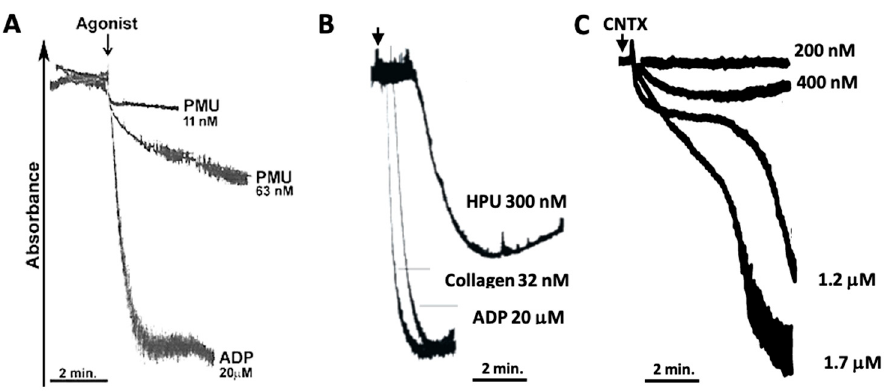
Figure 1. Aggregation of platelets induced by P. mirabilis urease and other ureases. Turbidimetric assay of platelet aggregation induced by ureases. The reaction started by addition of the agonist (urease, ADP, or collagen) to a platelet-rich plasma suspension and the aggregation response (a decrease in absorbance at 630 nm) was monitored for 5 min. The tracings were superimposed to facilitate comparison. Panel ( A ) aggregation of human platelets in the presence of PMU (11 and 63 nM) or 20 µM ADP. Typical results. Panel ( B ) aggregation of rabbit platelets in the presence of H. pylori urease (HPU, 300 nM), collagen (32 nM) or ADP (20 mM). Data adapted from [31]. Panel ( C ) aggregation of human platelets in the presence of canatoxin (CNTX, 200 nM, 400 nM, 1.2 mM, and 1.7 mM). Data adapted from [39].